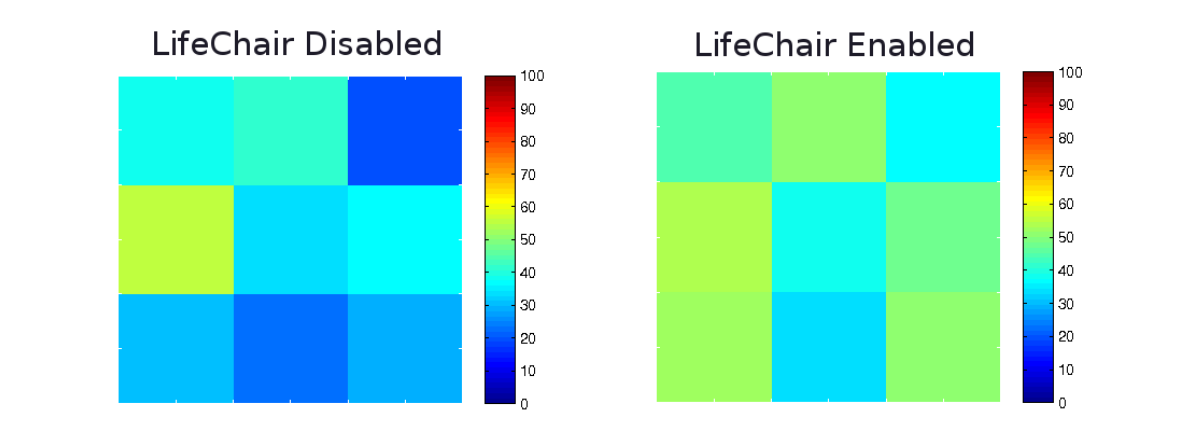
Figure 12. Heatmap of average pressure sensor activation per hour for all 10 participants when the LifeChair was disabled ( left ) and enabled ( right